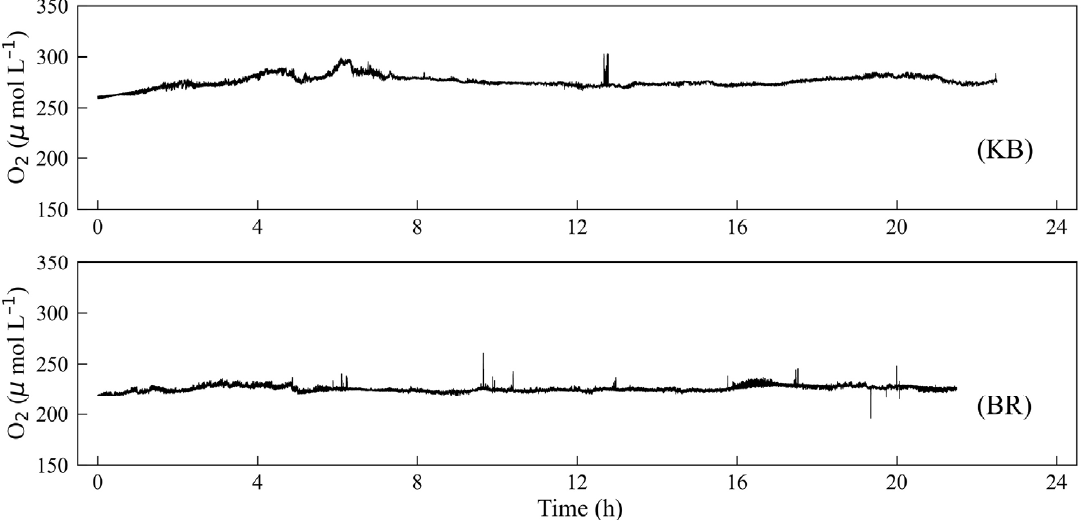
Figure 4. Time series of O 2 in KB and BR. Significant abnormal spikes were observed around 12–13 h in KB and excluded from further analysis.